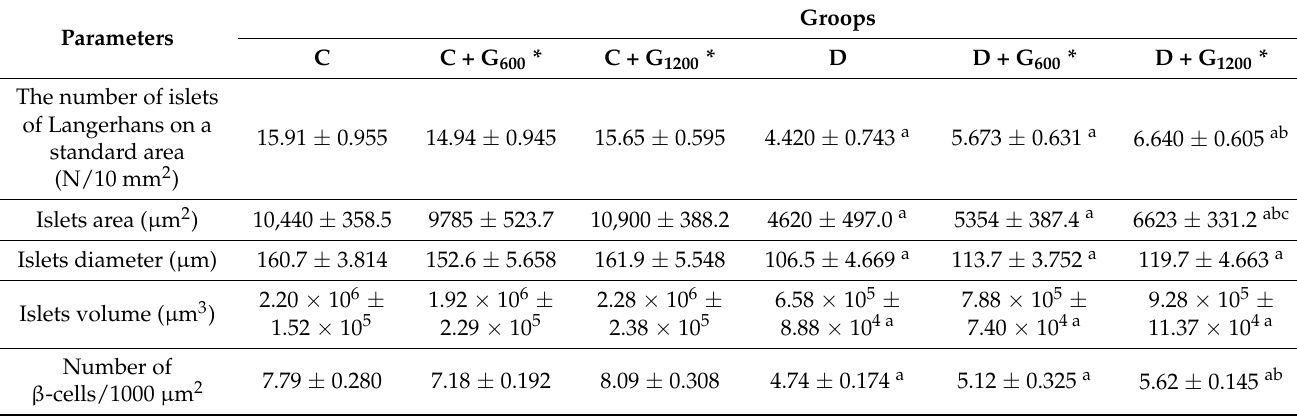
Table 1. Morphometric analysis of the incretory apparatus of rats during DM and on the background of Galega officinalis extract